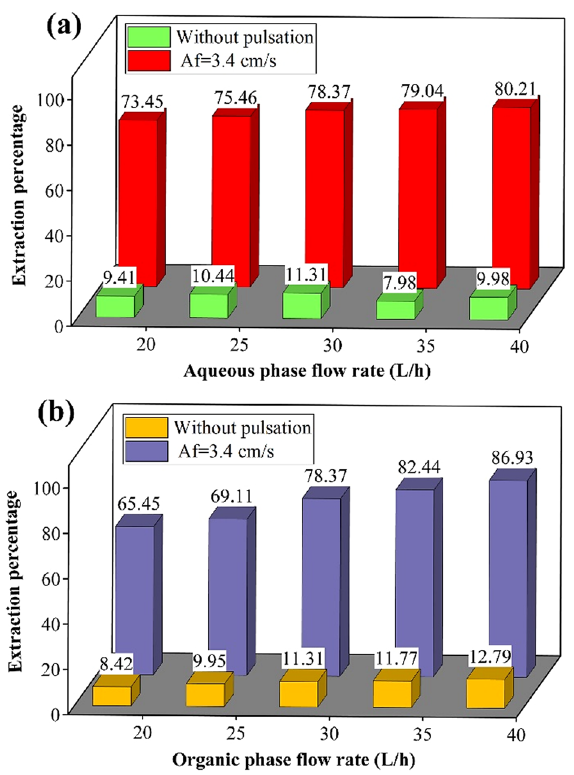
Figure 12. The influence of aqueous and organic phase flow rate on the extraction